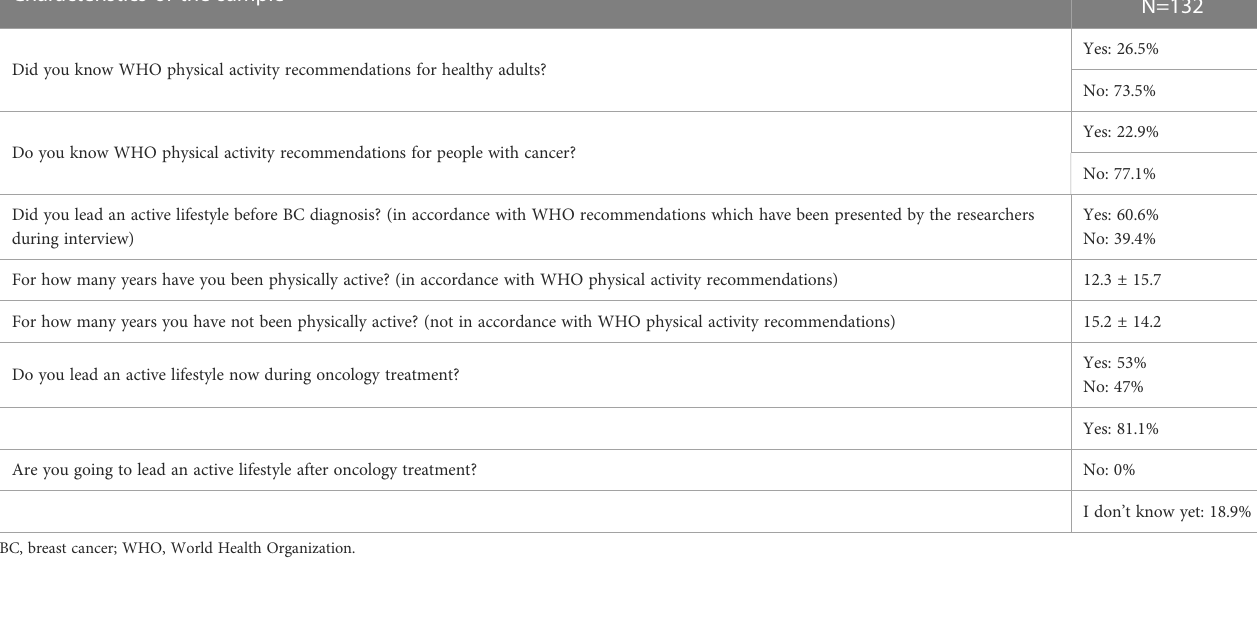
Characteristics of the sample